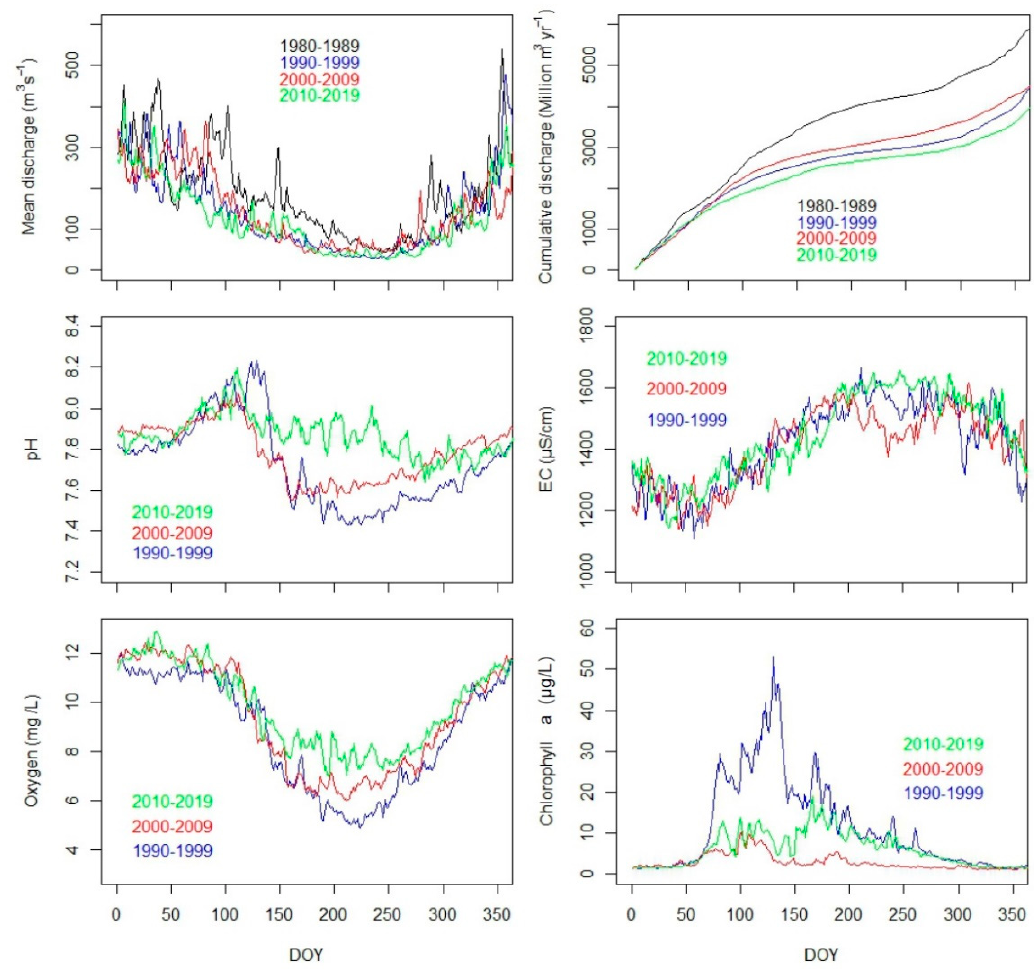
Figure 6. Annual cycles of discharge (daily and accumulated) in Perl and the four water quality parameters electric conductivity, chlorophyll a contents, oxygen and pH determined at Palzem. Data are calculated separately for the three decades 1990–1999 (blue lines), 2000–2009 (red lines) and 2010–2019 (green lines). For discharge, data for the decade 1980 to 1989 (black lines) are available as well.